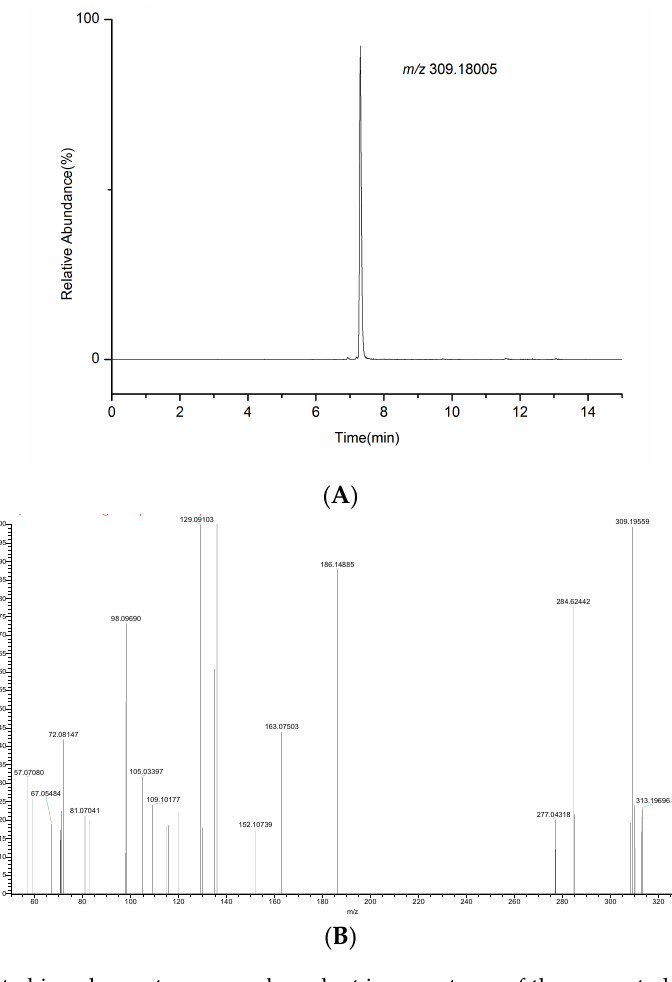
Figure 8. Extracted ion chromatogram and product ion spectrum of the suspected sample. ( A ) The extracted ion chromatogram of the suspected sample. ( B ) The product ion spectrum of the suspected sample.